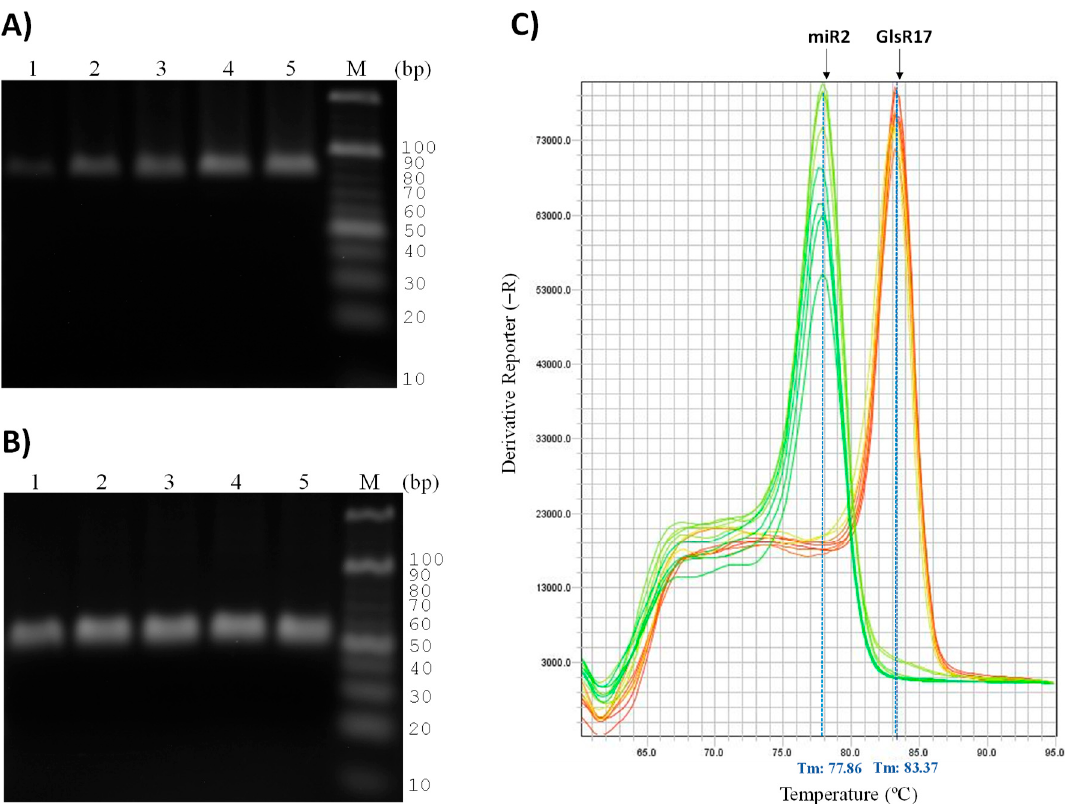
Figure 5. Amplification of the snoRNA GlsR17 and its derived miRNA (miR2) by PCR and RT-qPCR. Agarose gels (3%) with the PCR amplification products obtained with primers GslR17-Fw and UniLoop ( A ) and miR2-Fw and UniLoop ( B ) using different concentrations of template cDNA: lane 1: 0.025 ng, lane 2: 0.25 ng, lane 3: 2.5 ng, lane 4: 25 ng, lane 5: 250 ng. Lane M: O’RangeRuler TM 10 bp DNA Ladder (Thermo Scientific). PCR conditions were: 95 ◦ C for 30 s, and 40 cycles of 95 ◦ C for 3 s and 60 ◦ C for 30 s; ( C ) melt curves obtained for GlsR17 and miR2 amplification products by real-time PCR were generated using SYBR Green, and the same primers, template concentrations, and conditions as mentioned in A and B.